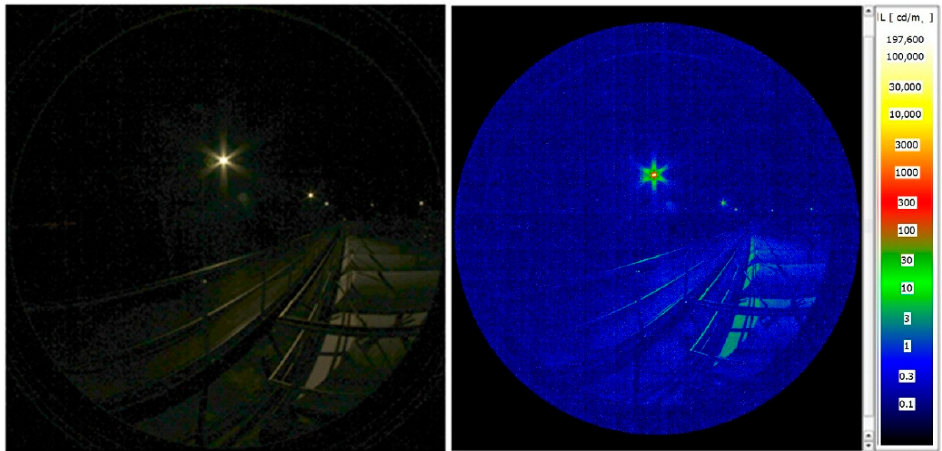
Figure 7. The view from the measurement point with corresponding luminance map. Measured GR = 62, subjective sensation of glare: disturbing, task of activity [5]: Handling of chemicals, inspection of leakage, changing of pumps, general servicing work, reading of instruments, GR MAX from standard [5] = 45. Similarly to Figure 5, in this case, the location of the glare sources determined the high level of glare (high GR value).